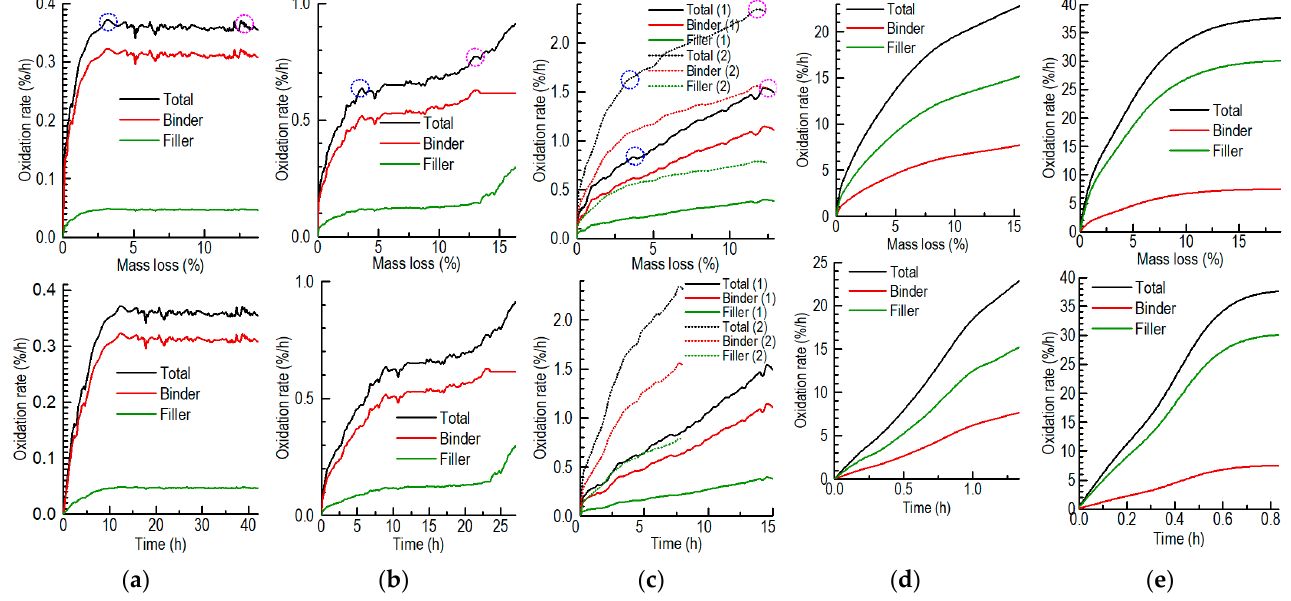
Figure 17. Oxidation rates of the whole specimen and binders and fillers of graphite ET-10 at 675–900 °C based on ASTM D7542: ( a ) 675 °C (chemically kinetics-controlled, regime I); ( b ) 700 °C (kinetics and in-pore diffusion mixed); ( c ) 725 °C (1) and 750 °C (2) (in-pore diffusion-controlled, regime II); ( d ) 850 °C (in-pore diffusion and boundary layer mixed); ( e ) 900 °C (boundary layer- controlled, regime III).